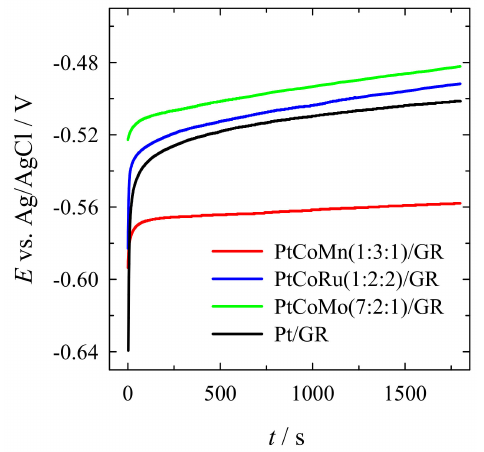
Figure 10. Chronopotentiometric data obtained on PtCoMn(1:3:1)/GR, PtCoRu(1:2:2)/GR, and PtCoMo(7:2:1)/GR catalysts recorded in a 1 M CH 3 OH +1 M NaOH solution at 2 mA cm − 2 for 1800